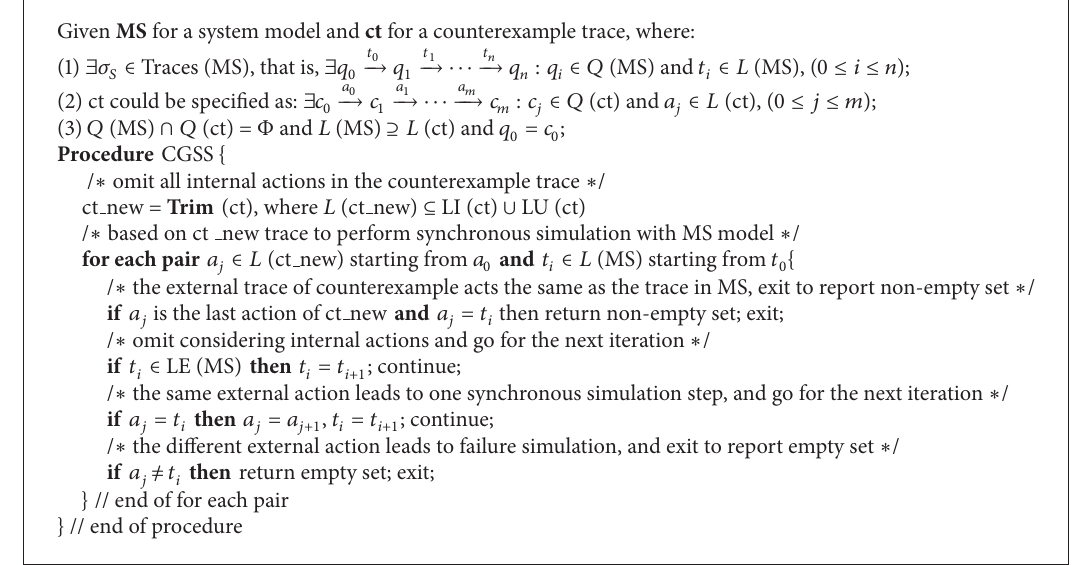
Algorithm 1: Counterexample-Guided Synchronous Simulation